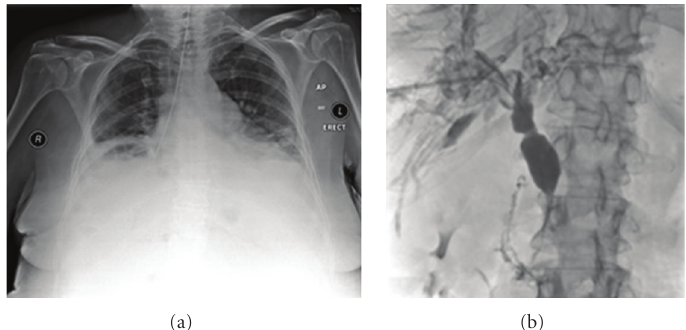
Figure 38: A CXR shows entry of the NGT into the right lower lobe bronchus. The patient was severely ill and went into respiratory distress following delivery of fluids down the NGT. There was a delay in the diagnosis of the patient developing an abscess at the right lung base. The patient had a cholangiocarcinoma and had an unsuccessful attempt at external biliary drainage (PTC (a)).